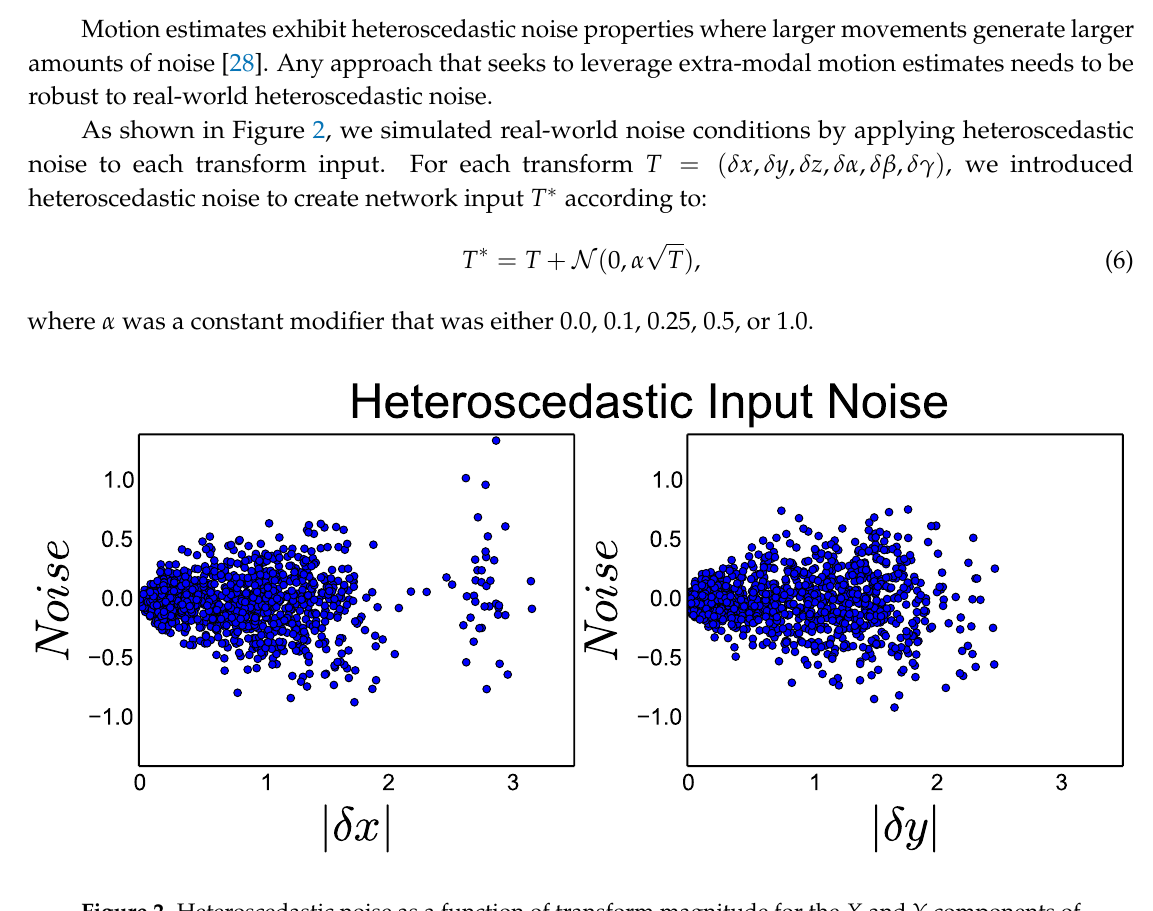
Figure 2. Heteroscedastic noise as a function of transform magnitude for the X and Y components of the transform input over the test set for a network with a noise parameter α =